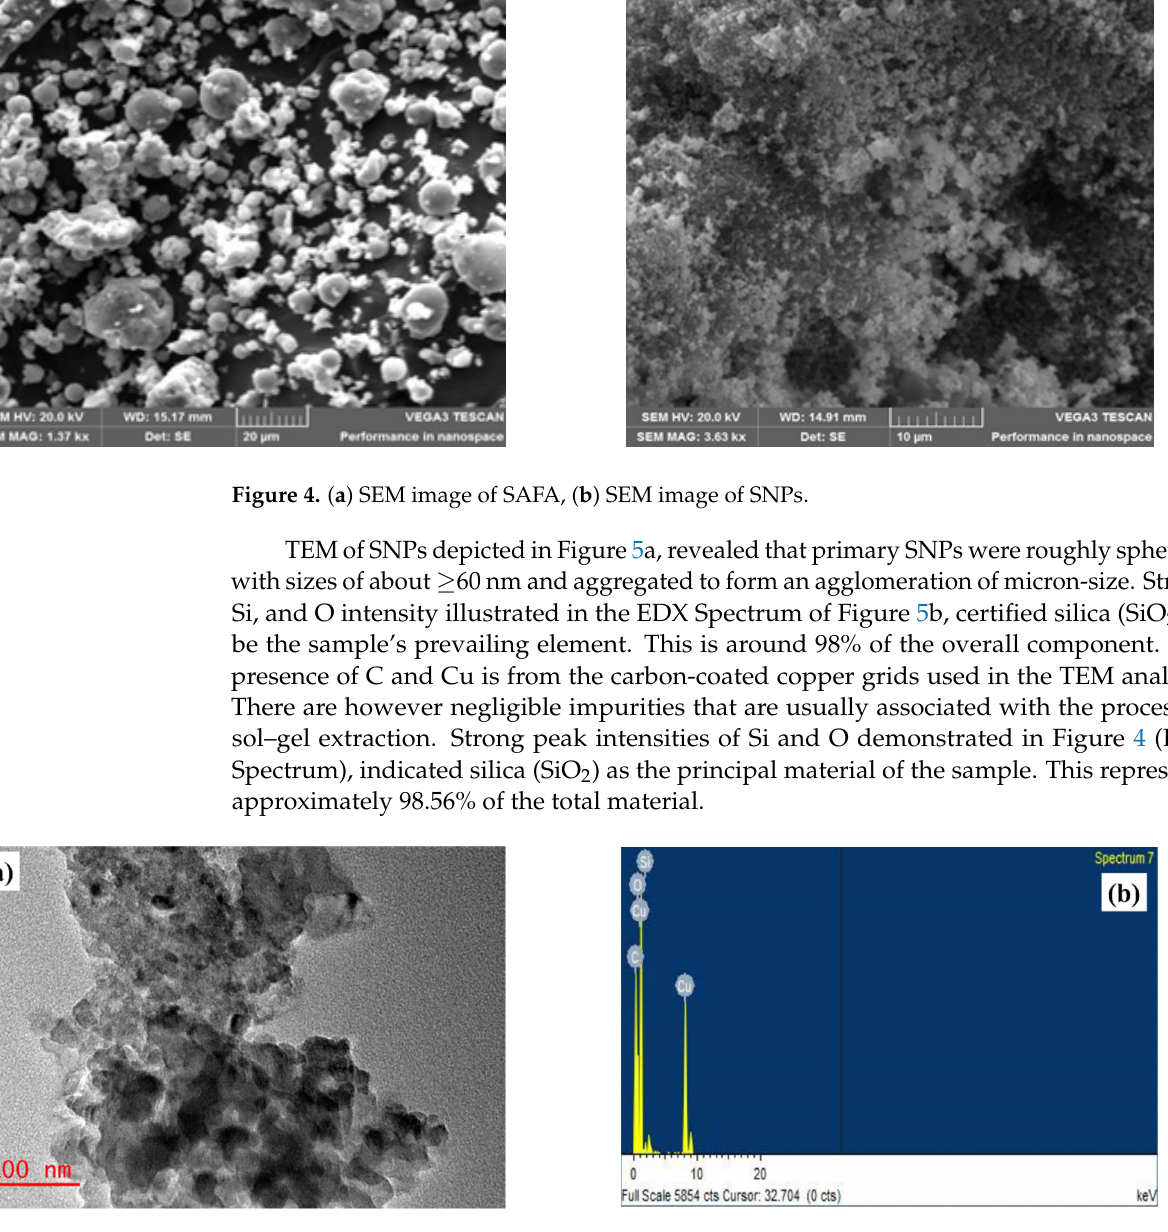
Figure 5. ( a ) TEM image of SNP ( b ) EDX of SNP.